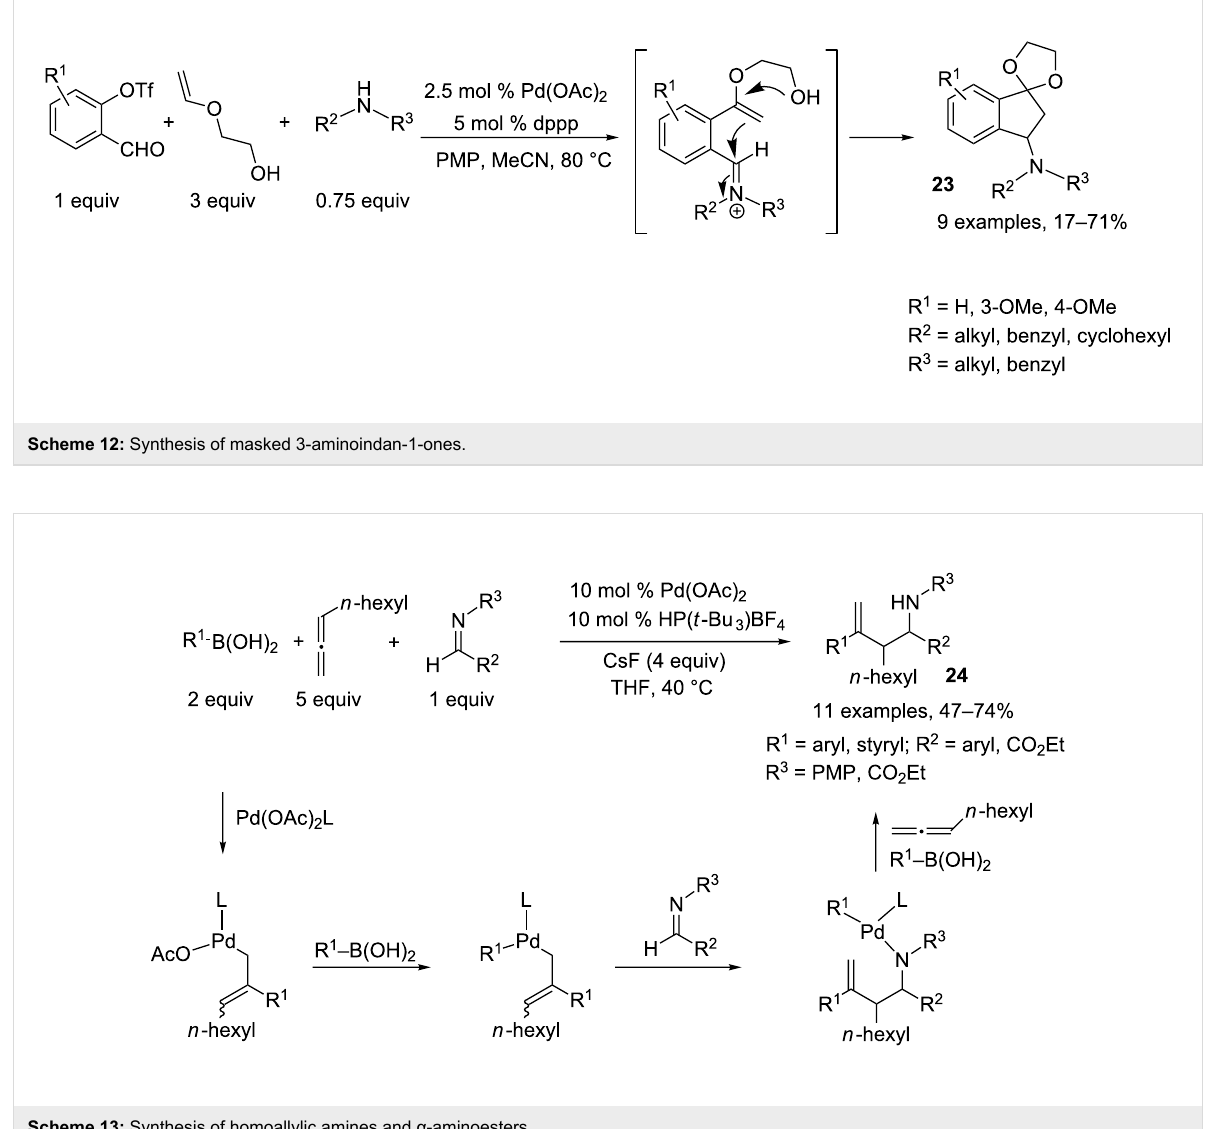
Scheme 13: Synthesis of homoallylic amines and α